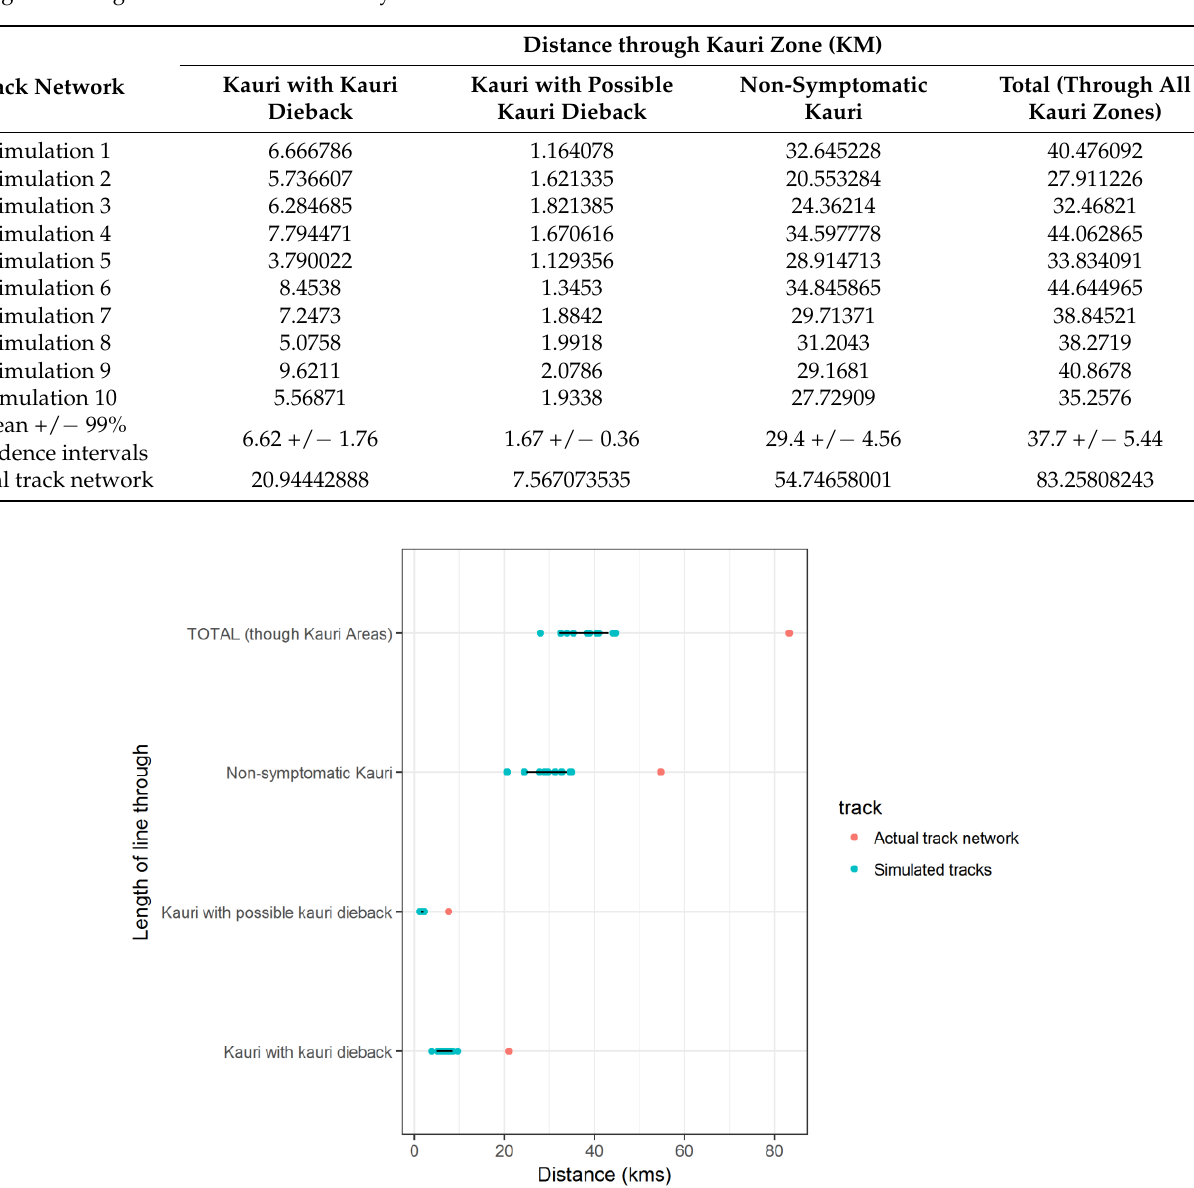
Table 2. Comparison of dieback along tracks (kms) between actual data from this survey and simulated tracks of the same length showing that dieback is more likely to be nearer tracks.